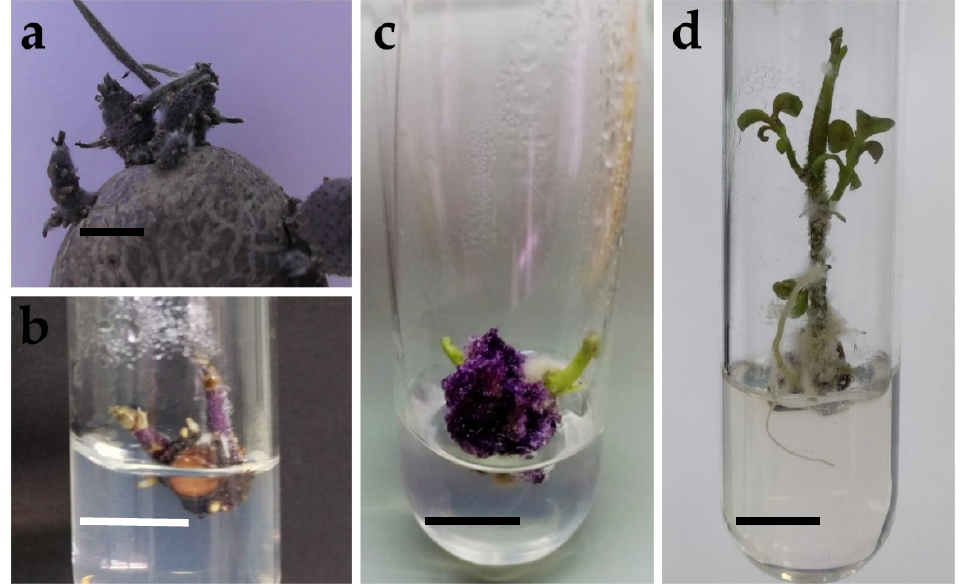
Figure 1. The in vitro initiation and subculture of PFPs; ( a ) sprouts of PFP tuber; ( b ) explant initiation; ( c ) hypertrophic process, purple callus generation, and shoot development on explant; ( d ) in vitro PFP complete plantlet development that is suitable for multiplication. Scale bar represents 1 cm.